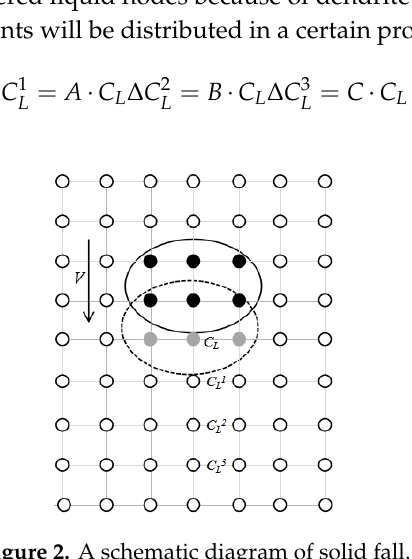
Figure 2. A schematic diagram of solid fall.